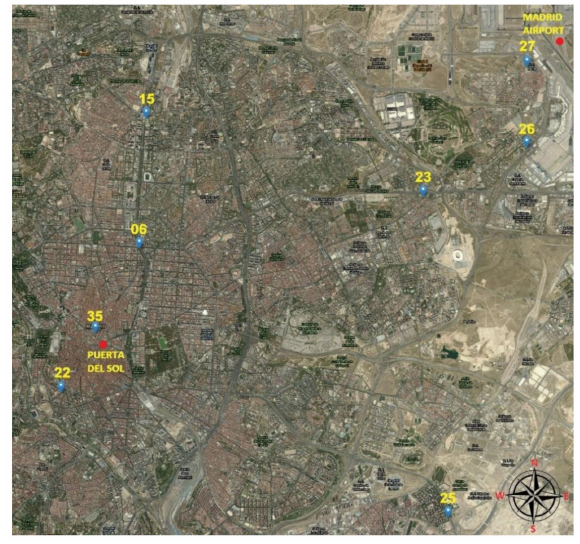
Figure 1. Location of stations in Madrid